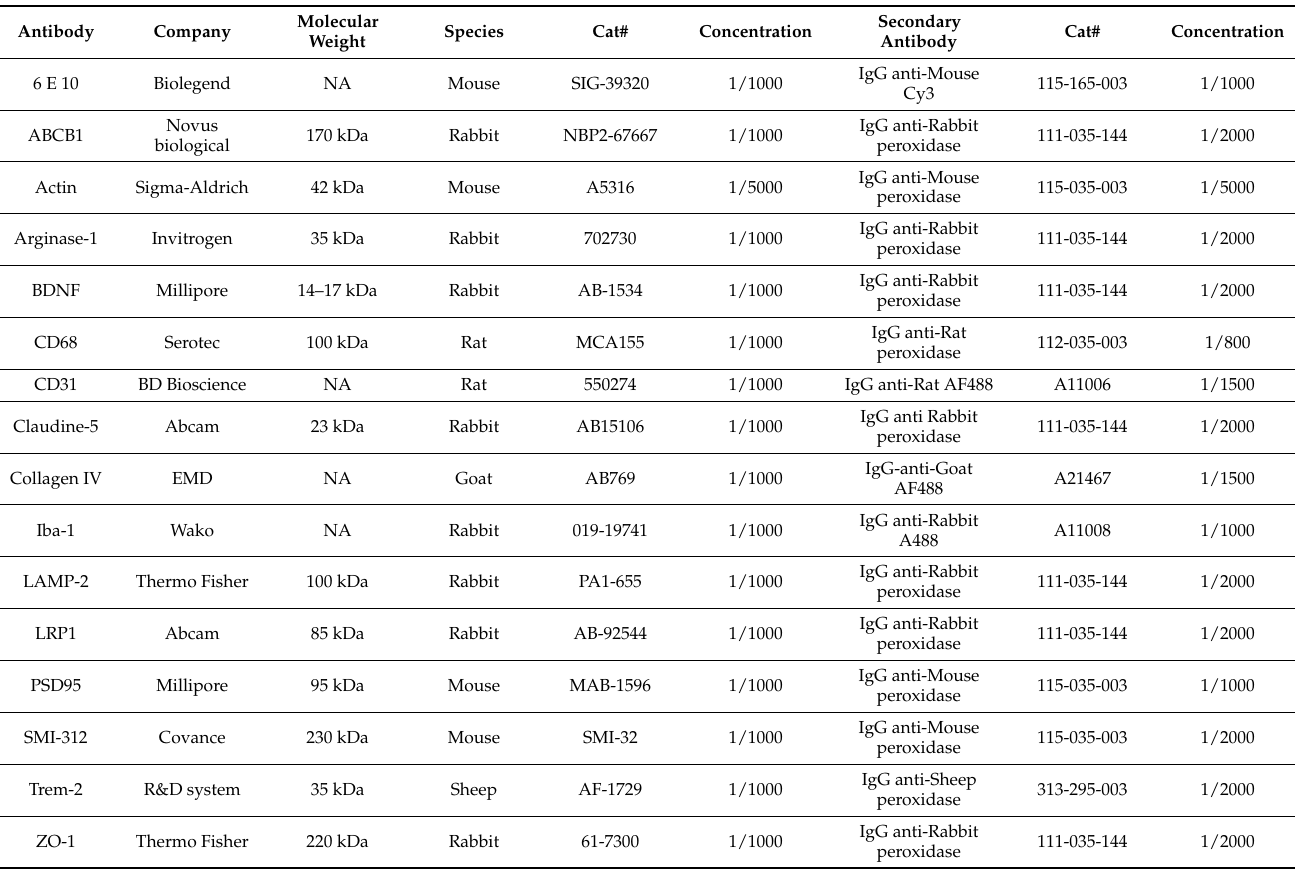
Table 1. List of antibodies used for the Western blot and immunostaining analyses and all related information, including the name of the company, molecular weight, species, primary and secondary antibody dilution, and